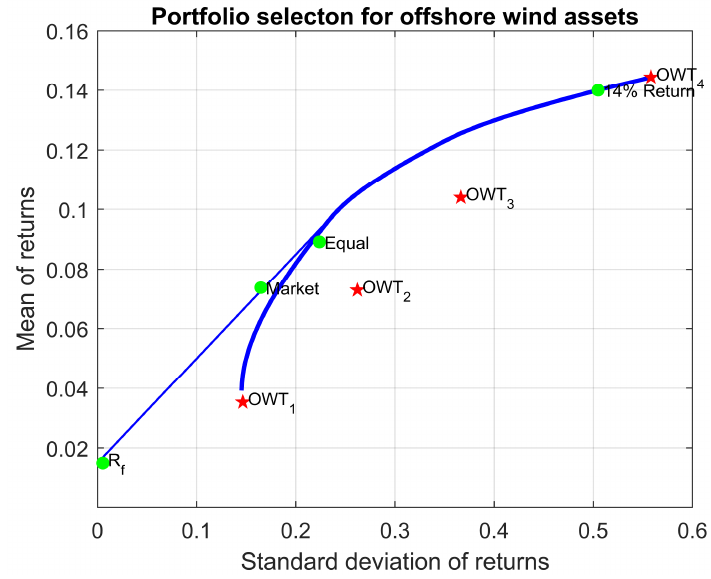
Figure 8. Mean value of returns as a function of standard deviation, 14% return and equal weights.